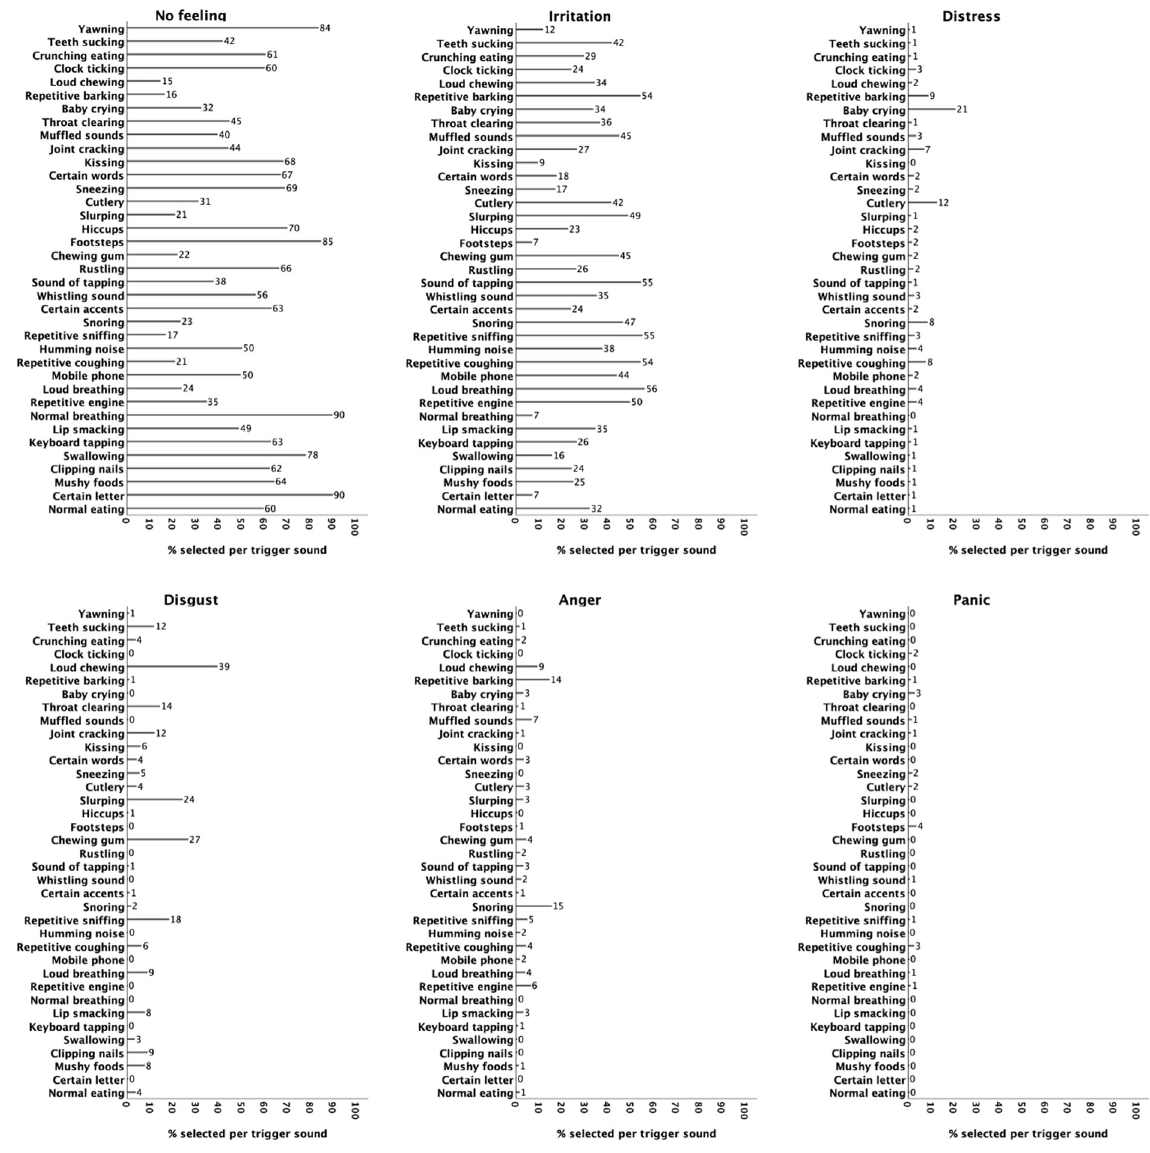
Fig 2. Percentages of selection per feeling per